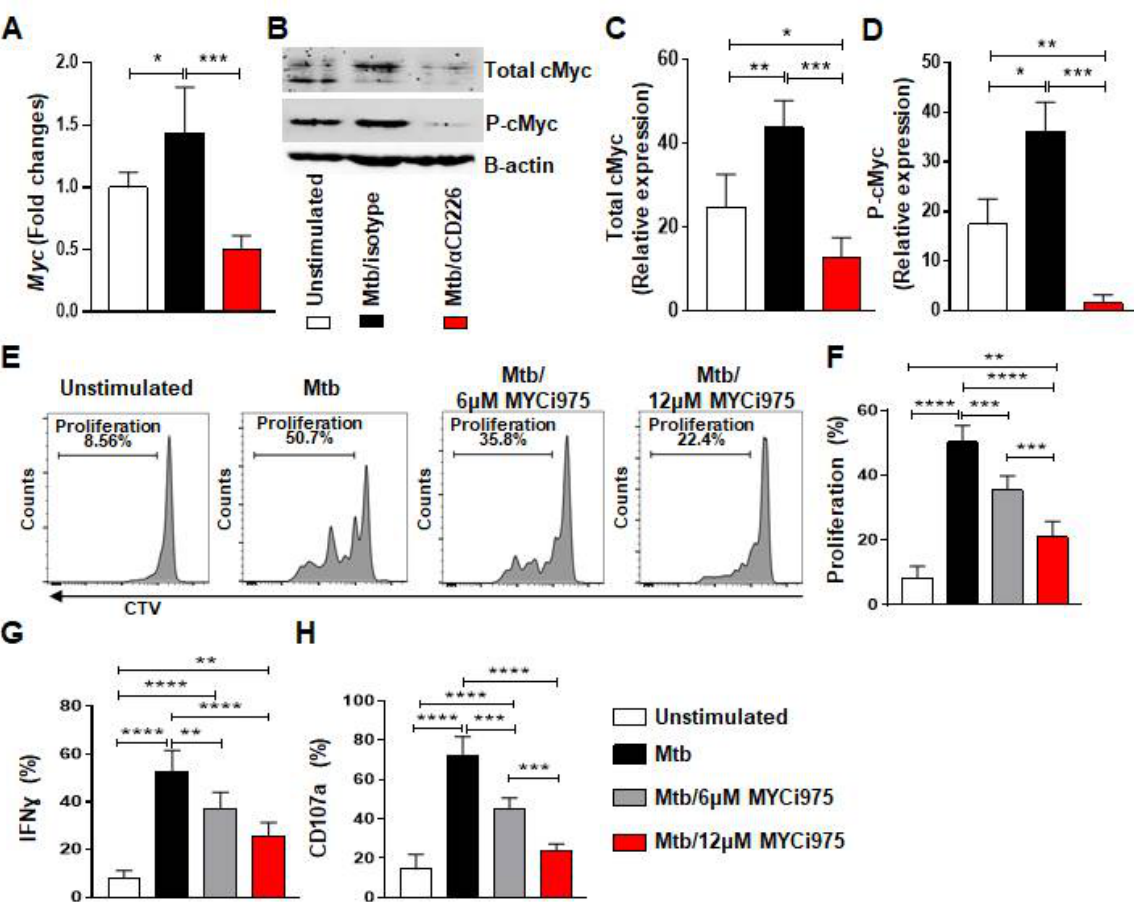
Figure 3. cMyc inhibition reduces effector function of mlNKs from LTBI+ people after stimulation with Mtb. ( A ) Myc gene expression by TaqMan PCR in NK cells after 24 h of stimulation with γ-Mtb and treatments with isotype or blocking CD226 antibody (n = 5). ( B ) Western blot for NK cells unstimulated or stimulated with γ -Mtb for 48 h and treated with isotype or blocking CD226 antibody (n = 5). ( C ) Total cMyc and ( D ) phosphorylated cMyc. ( E – H ) PBMC were stimulated with γ -Mtb or left unstimulated for 5 days. cMyc inhibitor CMYi975 (6 or 12 µ M) or DMSO vehicle was added every other day after stimulation with γ -Mtb ( E , F ) Proliferation of mlNKs from LTBI+ donors (n = 5) stimulated with γ -Mtb and treated with CMYi975 (6 or 12 µ M). ( G ) IFN- γ , ( H ) CD107a positive cells in CD3 − CD45+CD56+CD27+ cells (n = 5) unstimulated or stimulated with γ -Mtb and treated with CMYi975 (6 or 12 µ M). Mean ± s.d. ANOVA. * p < 0.05, ** p < 0.01, *** p < 0.001, **** p <